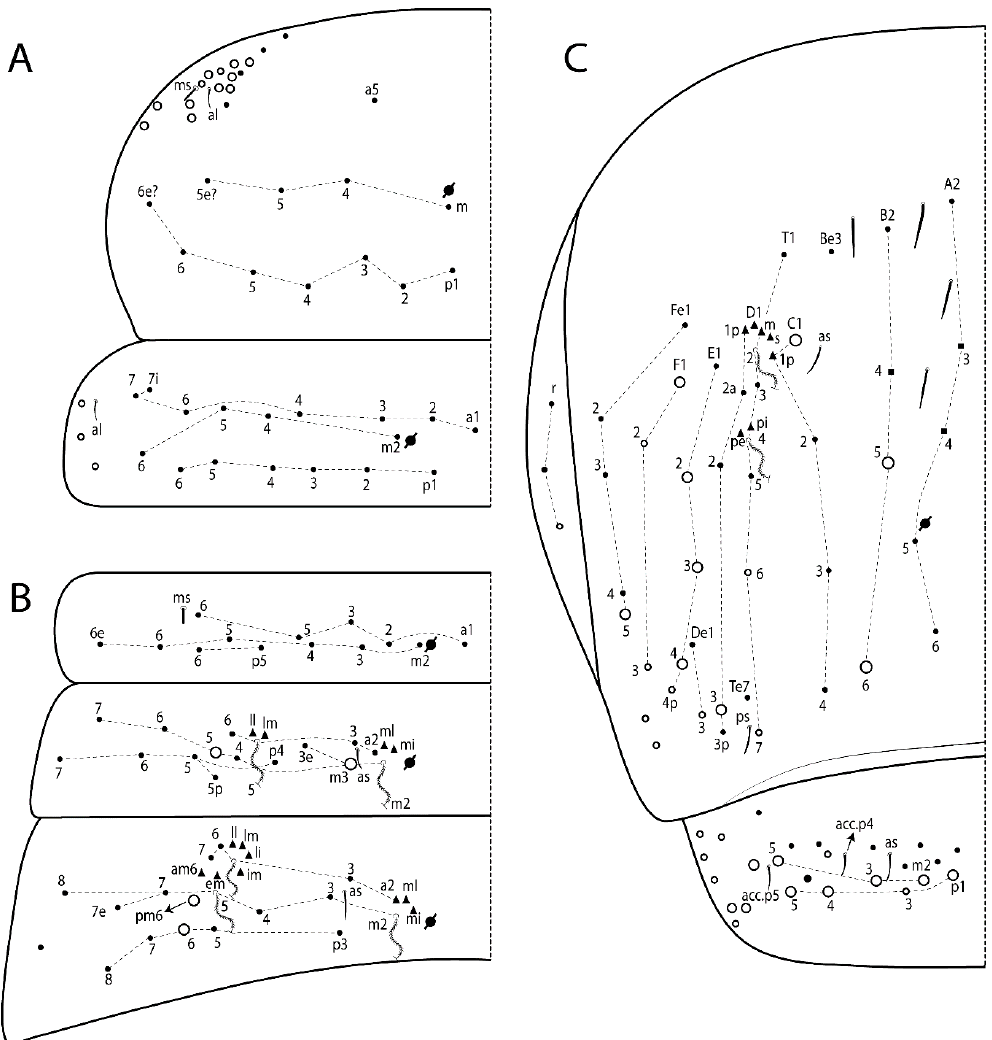
Figure 73. Pseudosinella parambigua sp. nov.: dorsal chaetotaxy. ( A ) Th II–III; ( B ) Abd I–III; ( C ) Abd IV–V.